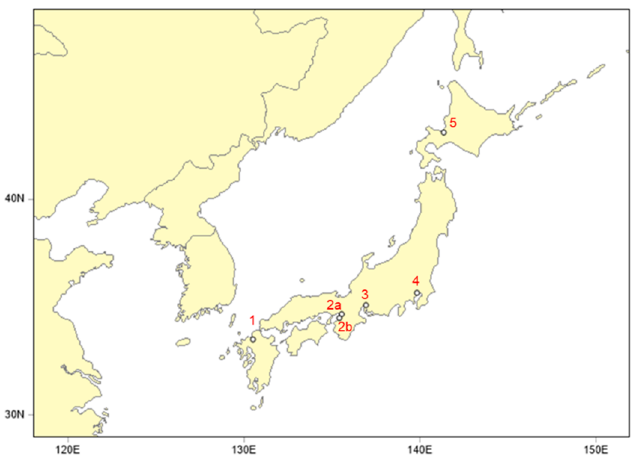
Figure 1. Locations of the PM 2.5 observation sites. Table 1. Location and sampler type used at the filter-based monitoring sites.